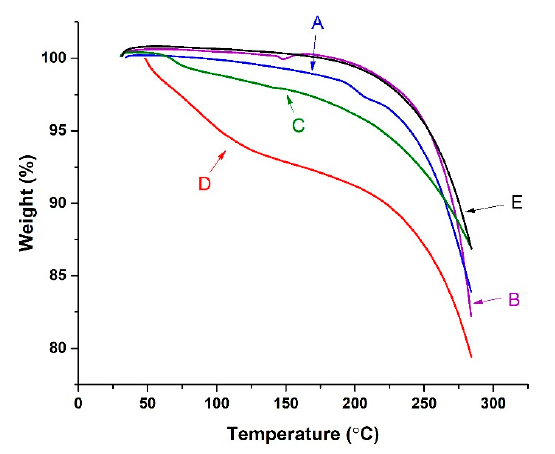
Figure 4. Thermogravimetric analysis (TGA) of chloroquine (A), cholesterol (B), Span ® 60 (C), empty niosomes (D), and chloroquine-loaded niosomes (E).